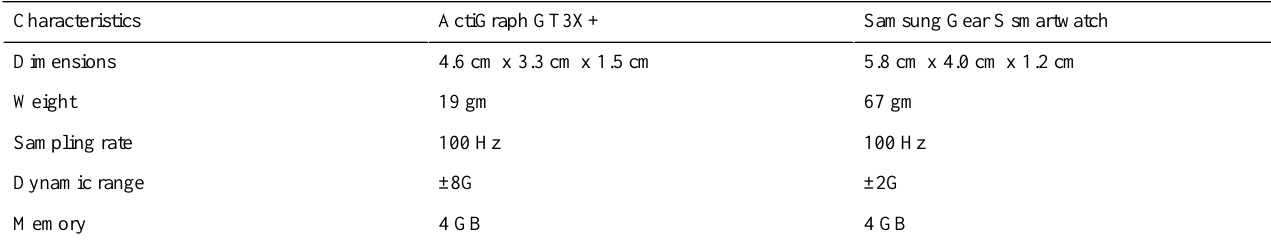
Table 1. Technical specifications of ActiGraph GT3X+ and Samsung Gear S smartwatch.